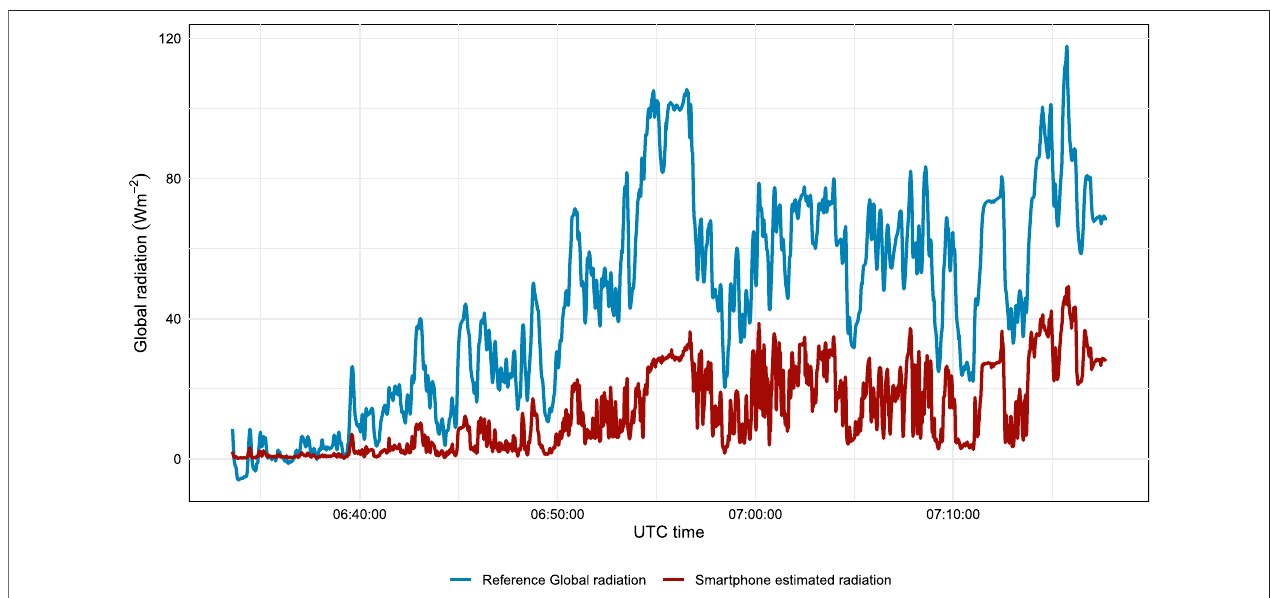
FIGURE9| ObservedlightsensorsignalfromSamsungS4(redline)andobservedglobalradiationatthesurfaceattheVeenkampenreferencestation(blueline)for a period of nearly three quarters of an hour. Measurements taken on October 19 th 2017.